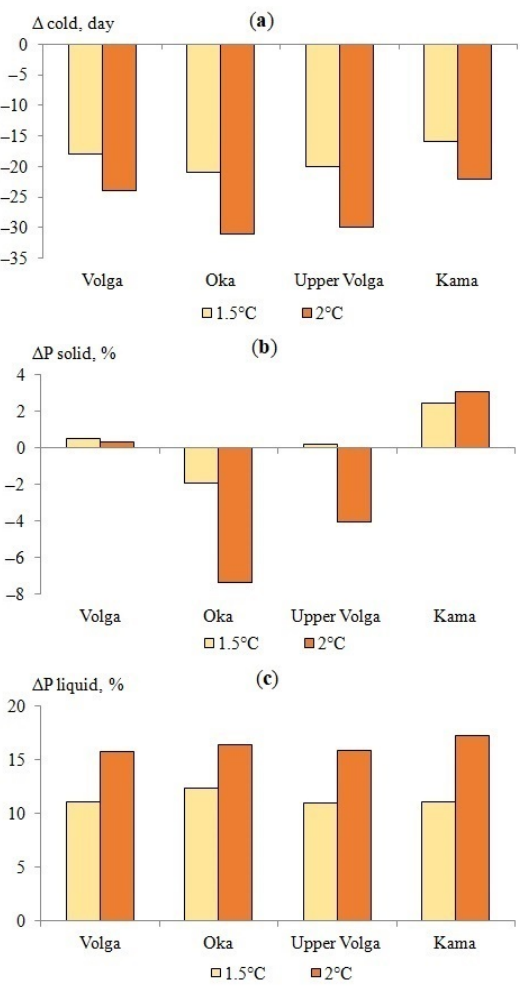
Figure 7. Anomalies of duration of the period with negative air temperature ( a ), solid ( b ) and liquid ( c ) precipitation in the Volga basin under global warming by 1.5 °C and 2 °C in the 21st century relative to the baseline period 1970–1999.